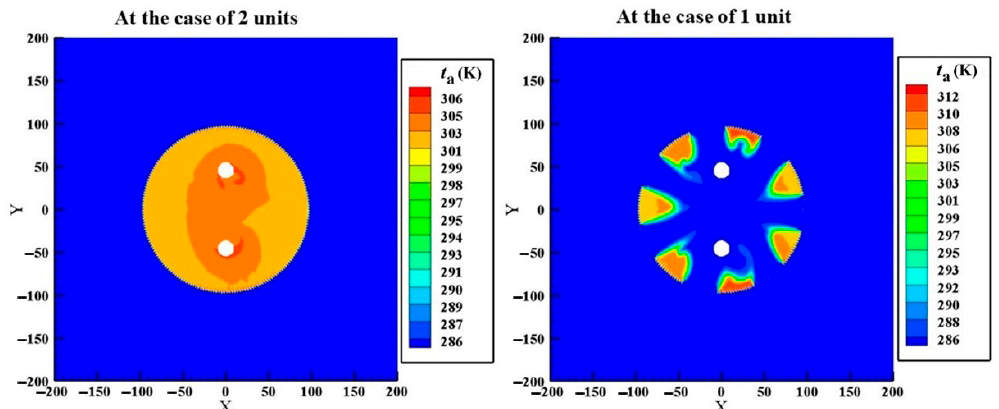
Figure 14. Comparison of temperature fields of ACHE under a typical crosswind of 4 m/s in the cases of 2 units and 1 unit.